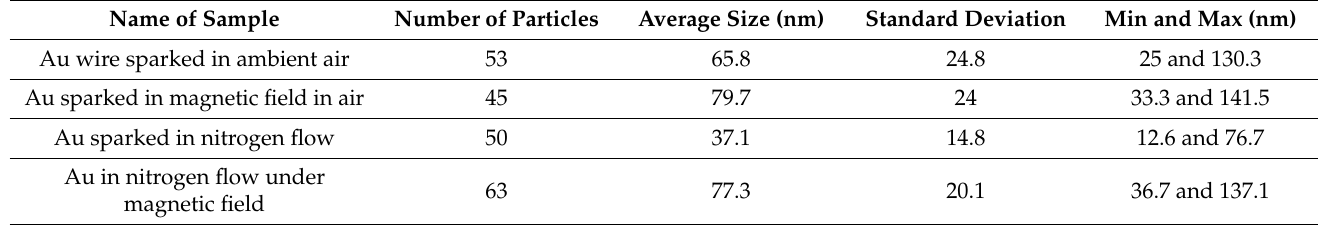
Table 1. Size distribution of particles calculated from SEM image using ImageJ